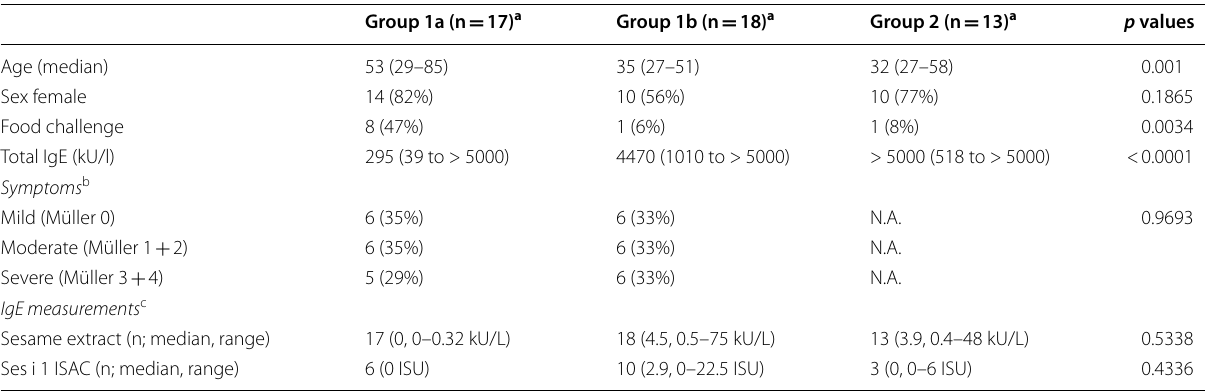
Table 1 Patient demography of included sesame allergic and tolerant patients; allergy was defined by food challenge or an experienced